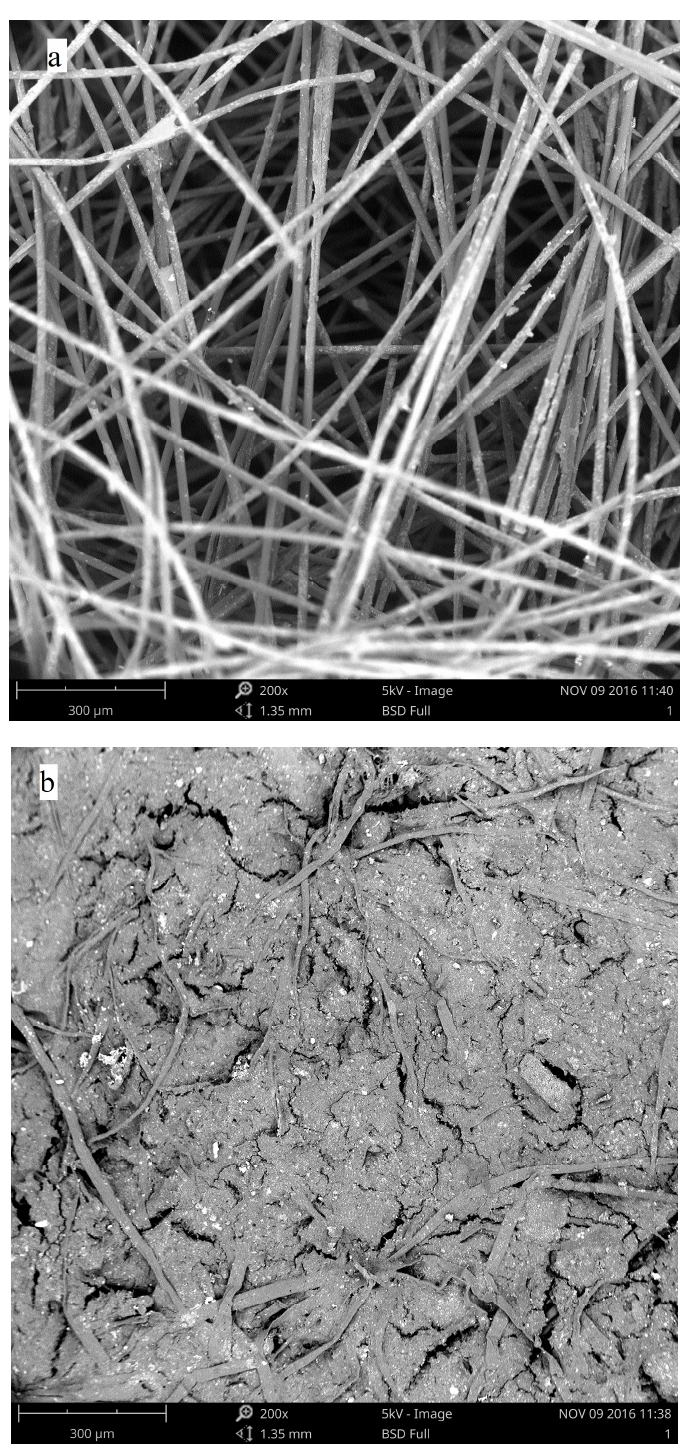
Figure 3. The SEM photos of the geotextile before ( a ) and after ( b ) the filtration test.